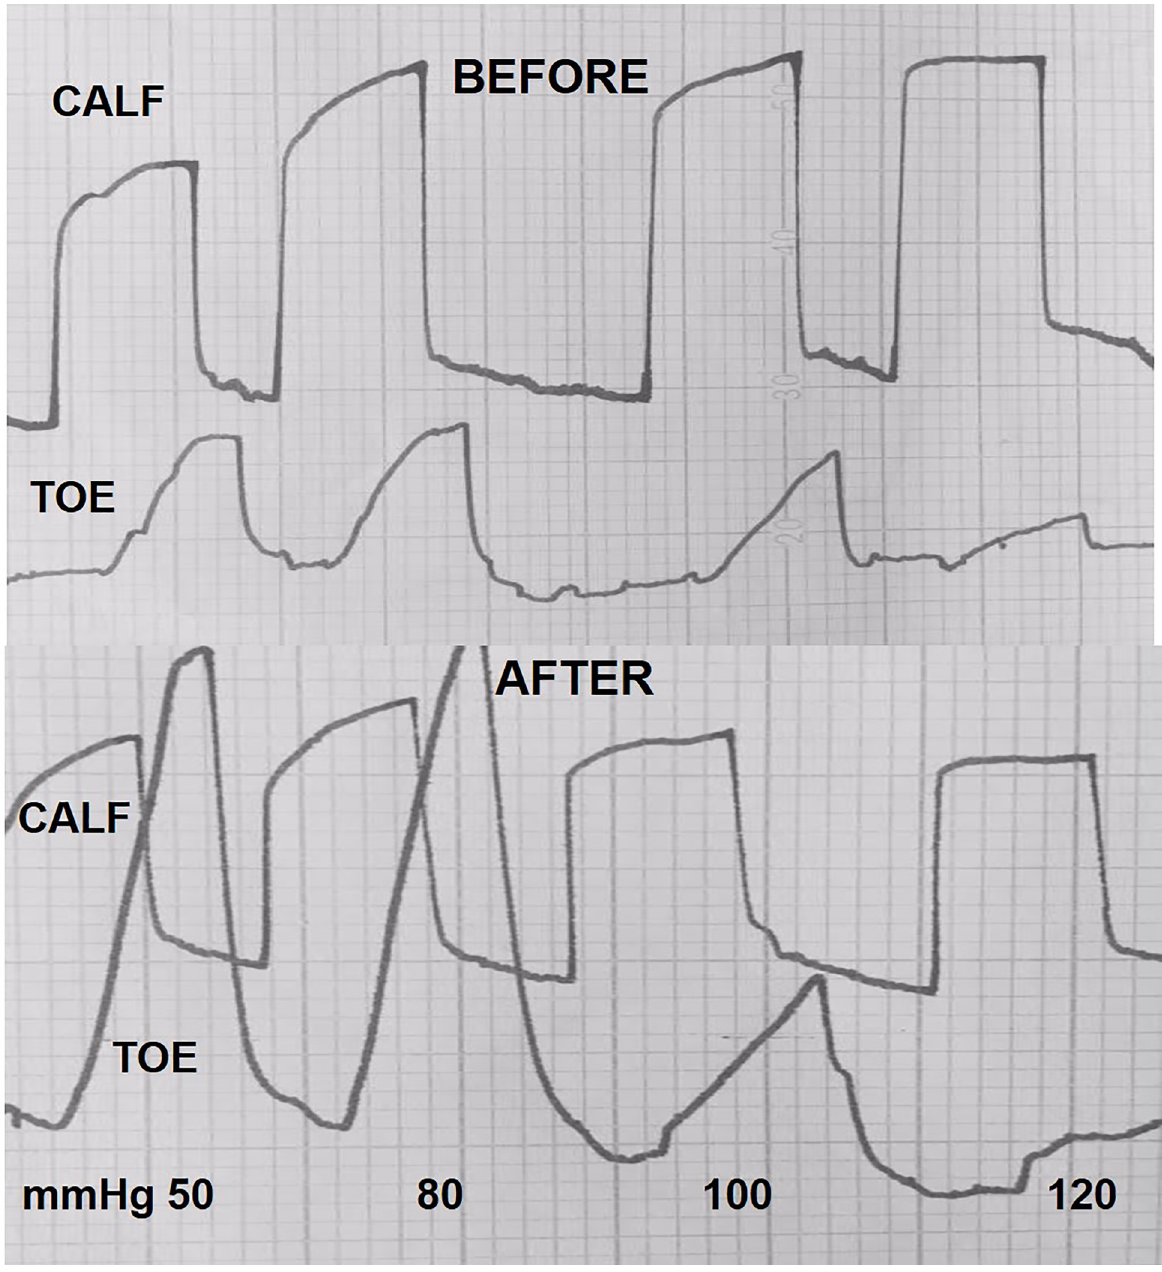
Fig 8. Venous occlusion plethysmography measuring arterial inflow at increasing occlusion pressures in a patient with multifocal changes in the calf arteries. Calf occlusion chamber was inflated to 50 to 120 mmHg pressures before and after 20 compressions of the designed arterial assist pump. Simultaneous recordings in the calf and big toe. Curves show increase of circumferences at each applied 0 mmHg occlusion pressures. Before compression: calf–fast rise of curves reaching same level at occlusion pressures up to 120mmHg, big toe- decreasing peak of circumference at occlusion pressures 100 and 120 mmHg. After compression: calf- no evident difference with before arterial assist, big toe- peaks higher than before assist. The difference may be due to the increase in capillary